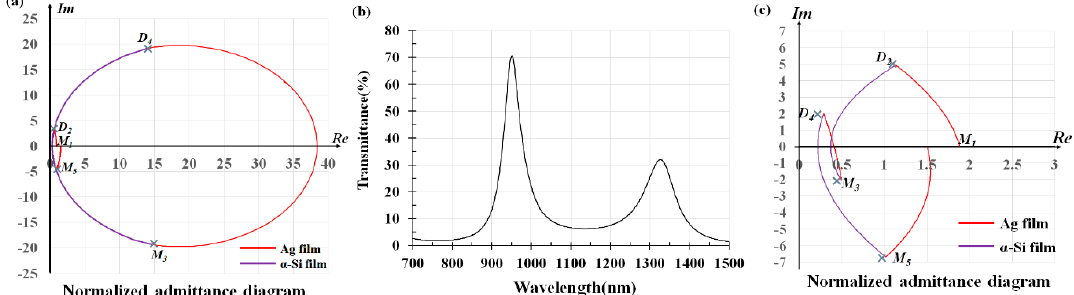
Figure 1. ( a ) Normalized admittance diagram (NAD) loci of modified five-layered filter with structure N i / M 1 D 2 M 3 D 4 M 5 / N sub ; ( b ) transmittance spectrum of five-layered system; ( c ) NAD loci at a wavelength of 1326 nm.